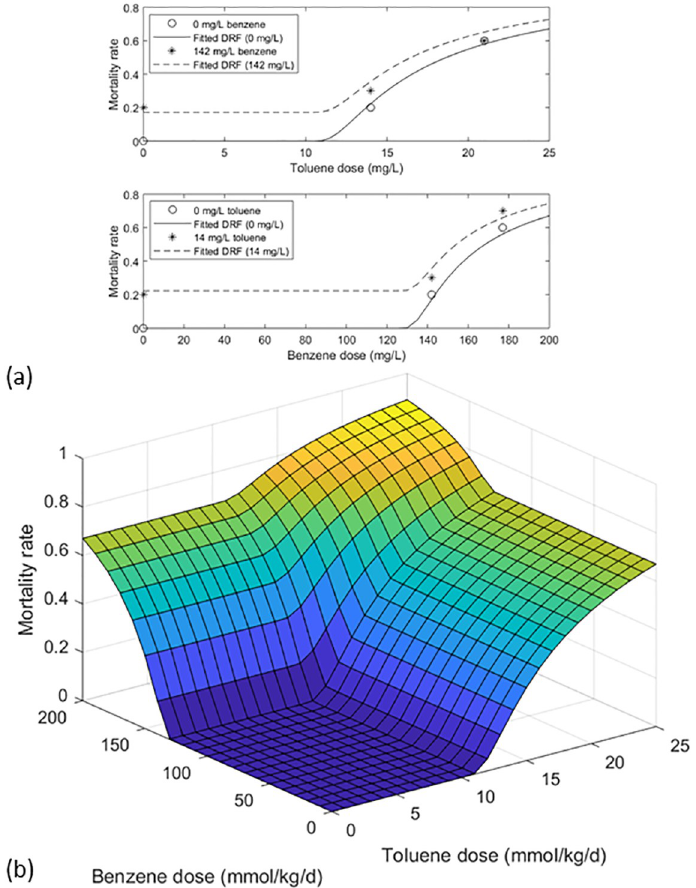
Fig 7. First-order dissimilar mode DRF fitted to the data of Fig 6. (a) mortality versus toluene dose, with and without 142 mmol/kg/d benzene, and mortality versus benzene dose, with and without 14 mmol/kg/d toluene; and (b) joint fitted DRF for mortality, assuming no